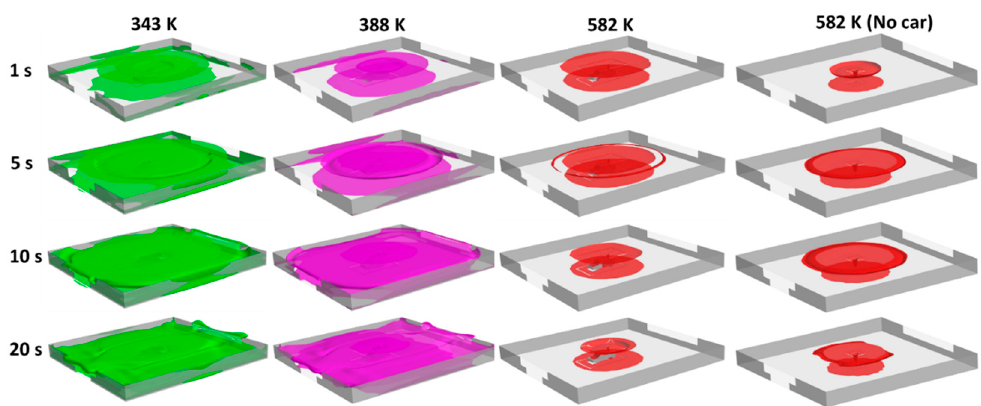
Figure 6. Iso-surfaces showing no-harm (343 K), pain limit (388 k) and fatality limit temperature (582 k) for ignited hydrogen release in case 3 (TPRD = 2 mm, upward release from distance 1.13 m from the ceiling with tank blowdown and car body) and case 2 (TPRD = 2 mm, upward release from distance 2.1 m to the ceiling with tank blowdown, no car body).